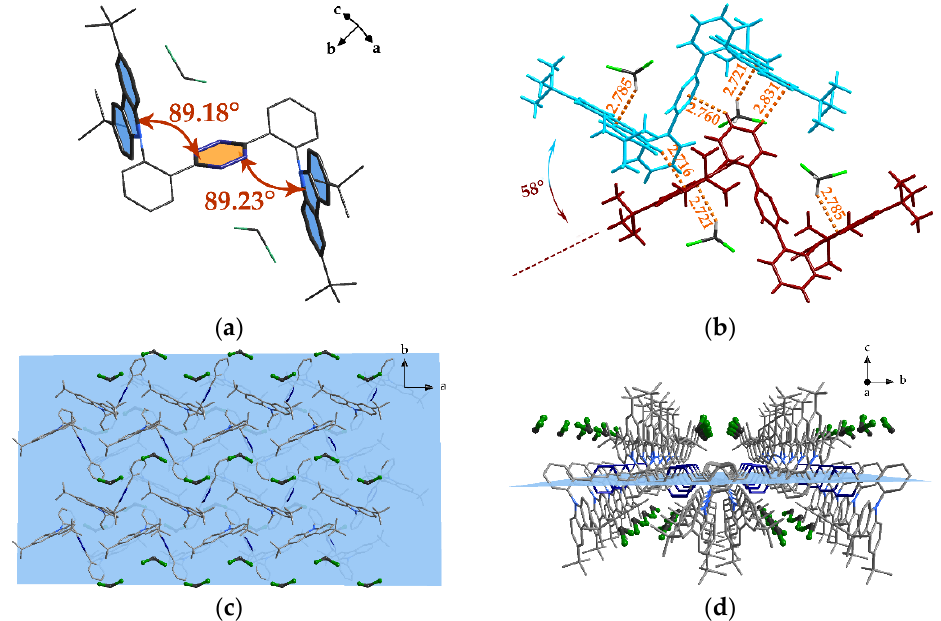
Figure 2. ( a ) The dihedral angle between the central pyrimidine plane and carbazole plane in PDPC ; ( b ) intermolecular interactions between adjacent molecules and their surrounding solvent molecules, in which the PDPC molecules are colored as red and cyan; ( c , d ) the PDPC molecules packed in space, viewed in the c and a directions. The blue plane indicates the horizon where the central pyrimidine rings stand. The hydrogen atoms in subfigures ( a , c , d ) were omitted for clarity.